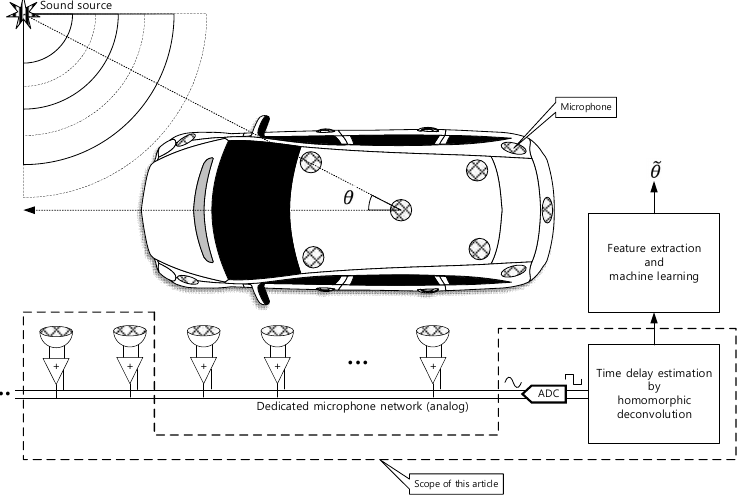
Figure 1. Functional diagram of overall SSL system for transport. This paper presents the parametric and non-parametric homomorphic deconvolution for two-microphones situation. The car shape is illustrated by Nichkov Alexey [13].